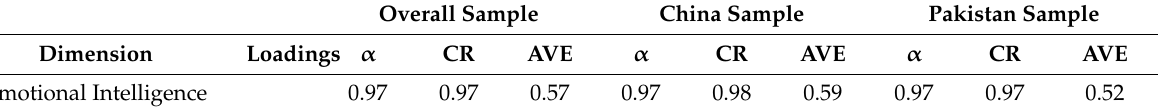
Table 5. Item Loadings, Reliability, and Convergent Validity for overall Chinese and Pakistani Samples. Overall Sample China Sample Pakistan